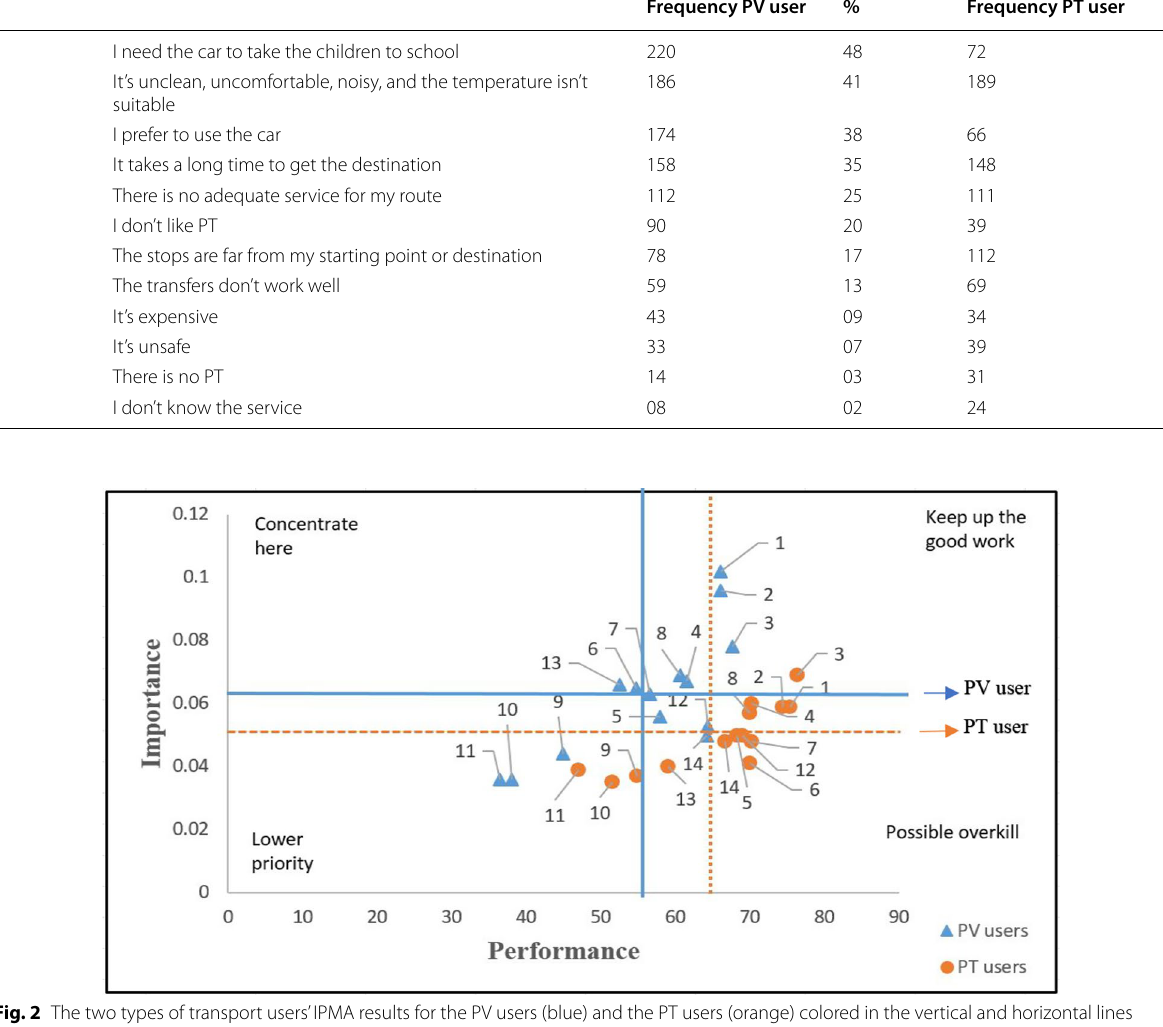
Fig. 2 The two types of transport users’ IPMA results for the PV users (blue) and the PT users (orange) colored in the vertical and horizontal